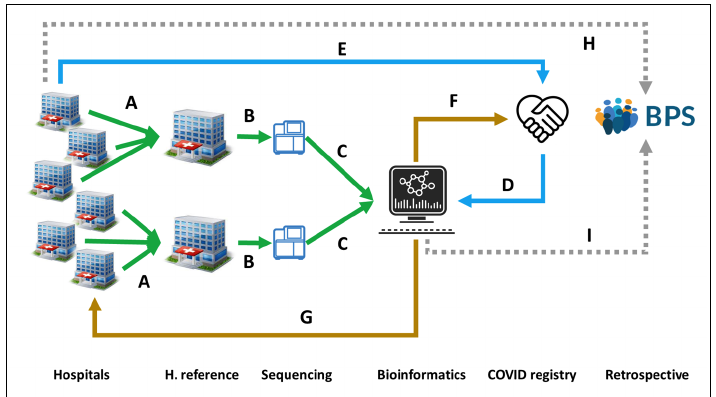
Figure 1. Circuit for COVID19 genomic surveillance. ( A ) Two reference Hospitals, San Cecilio and Virgen del Rocio, collect SARS-CoV-2 samples from Eastern and Western Andalusia, respectively. ( B ) Samples are sent to GENYO or IBIS sequenc- ing facilities. ( C ) Sequencing data are sent to the Bioinformatics Area for processing and ( D ) linking to metadata from the COVID registry, ( E ) previously collected from the Hospitals. ( F ) Bioinformatics reports relevant epidemiological infor- mation to the COVID registry and ( G ) information on lineages and variants to the Hospitals for supporting clinical deci- sions. ( H ) Clinical data on COVID-19 patients recorded in the Hospitals is stored in the BPS. ( I ) Viral genomes are also stored in BPS linked to the rest of the patient’s clinical data for further secondary use.